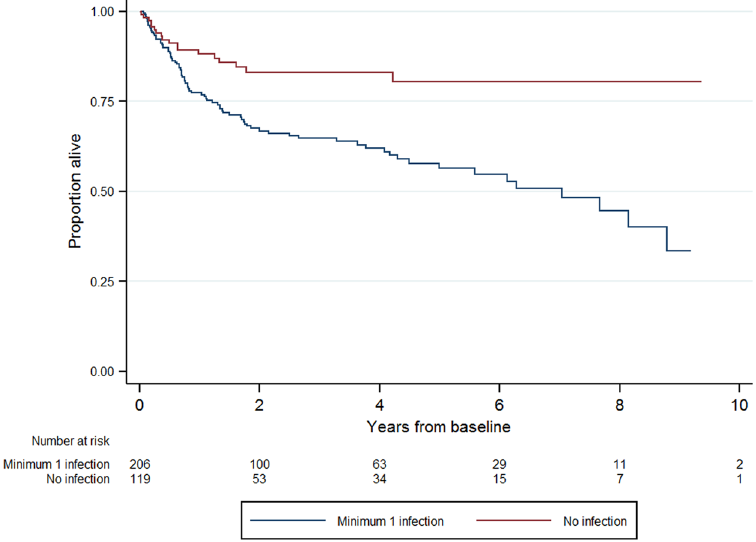
Figure 1. Survival analysis of DLBCL patients who had at least one infectious episode compared with those who did not have an infectious